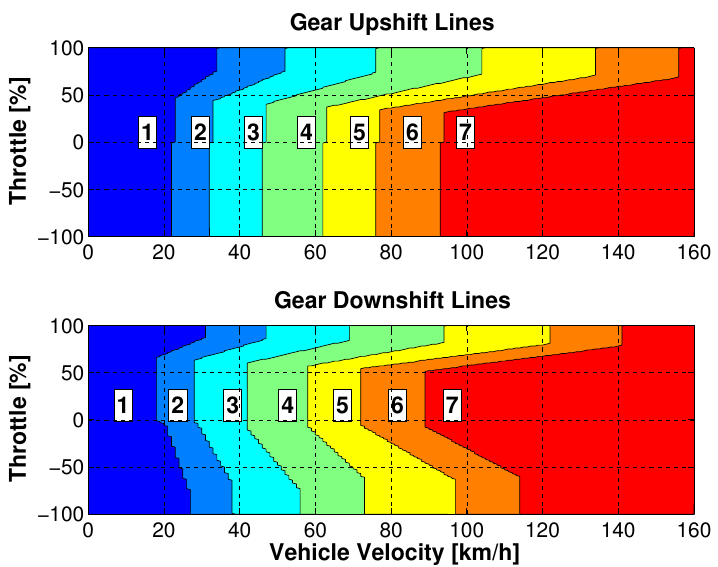
Figure 4. Heuristic gearshift